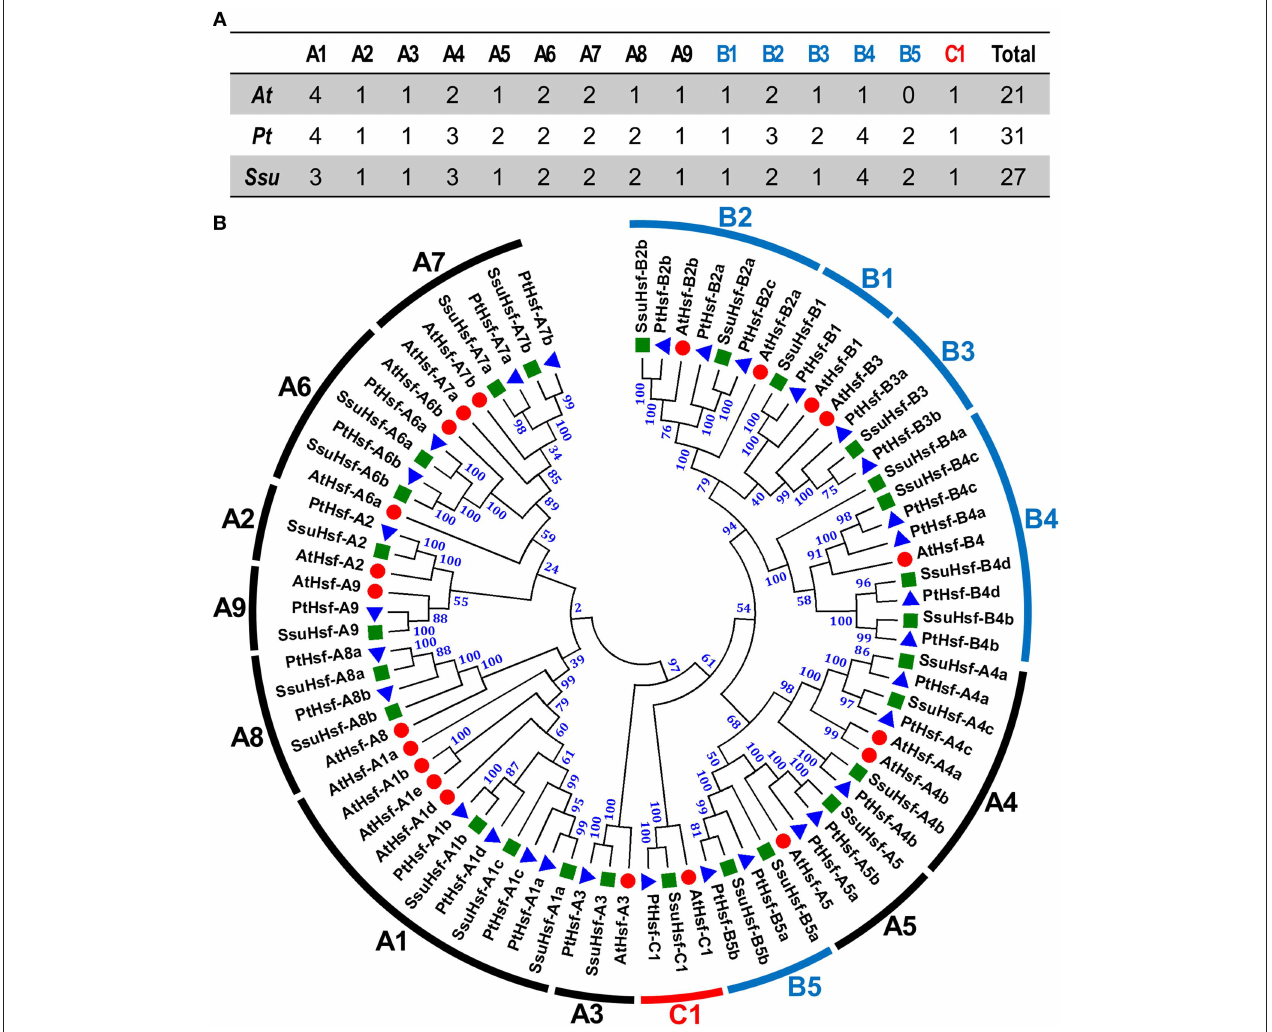
FIGURE 1 | Hsf family members (A) and their phylogenetic relationships (B) from S. suchowensis , P. trichocarpa , and A. thaliana . Multiple alignment was performed using Clustal X 2.1. Phylogenetic tree was constructed by the neighbor-joining (NJ) method with 1000 bootstrap replicates. Bootstrap support values are indicated on each node. The three major groups are marked with different colors. The complete sequences of identified Hsfs are listed in Table S1 . Hsfs in S. suchowensis , P. trichocarpa , and A. thaliana were marked with green squares, blue triangles, and red circles, respectively.